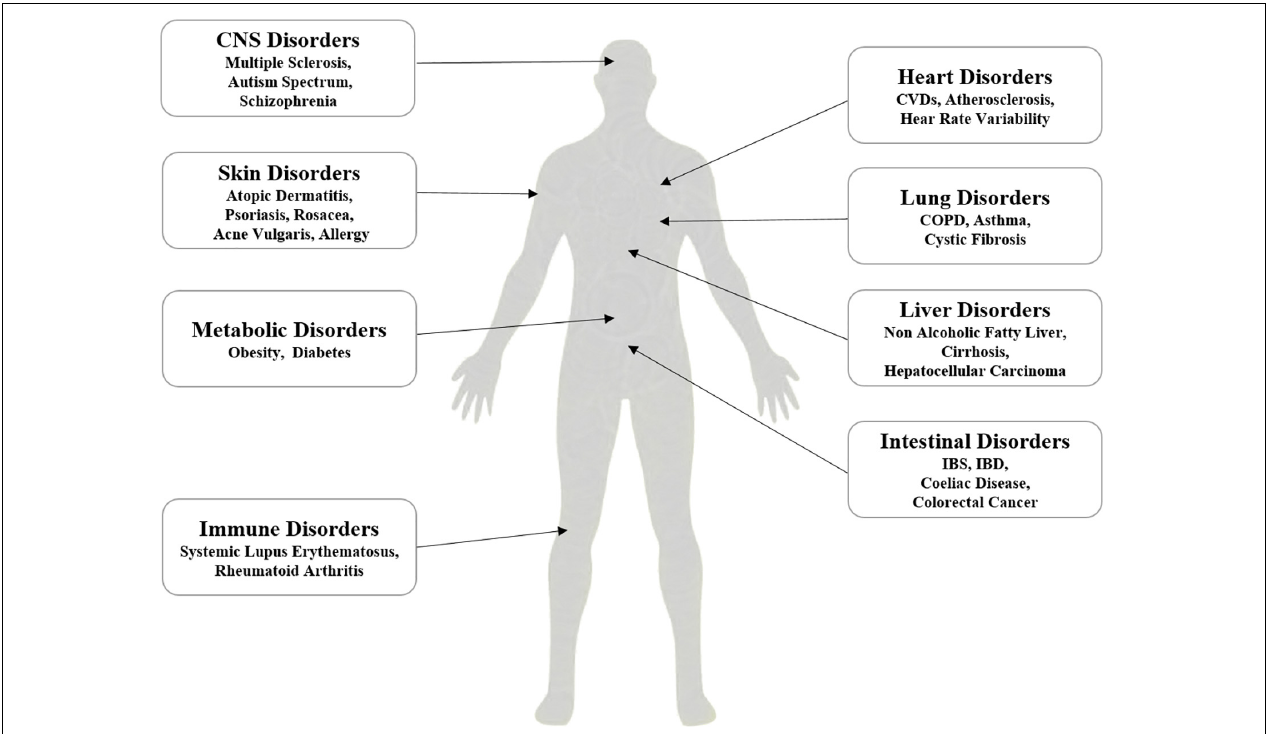
FIGURE 3 | Proposed association of dysbiosis of intestinal microbiota with systemic disorders, which include the disorders related to liver, lung, heart, gut, skin, metabolic, immunity and